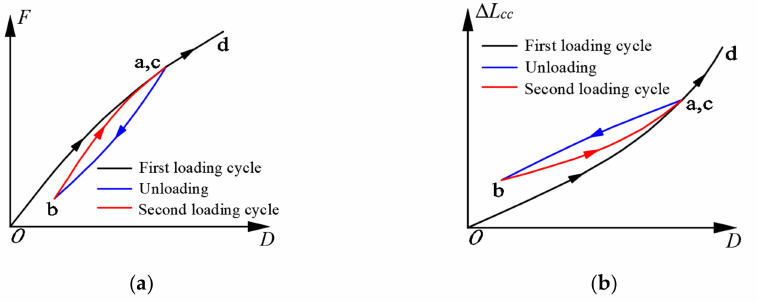
Figure 15. Conceptual diagrams of the BFRP tendons: ( a ) force-displacement curve; ( b ) anchor colloidal